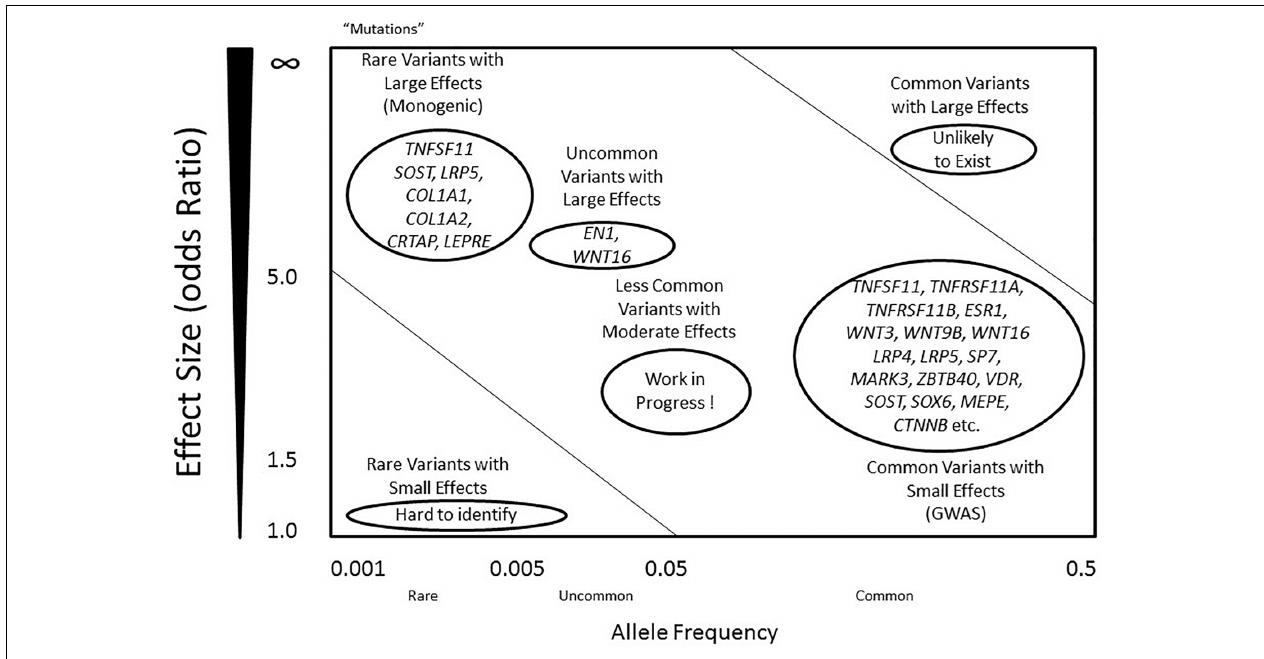
FIGURE 1 | Genetic predisposition and architecture in osteoporosis. Allele frequency is defined as below: common ( < 0.5), uncommon ( < 0.05), and rare ( < 0.005). Mutations are considered as rare variants, mostly with an allele frequency less than 0.001, often with large effect sizes. Alleles that contribute to regulation of BMD include rare variants with large effects (left top), and common variants with small effects (right bottom). A few genes such as COL1A1 and LRP5 include variants that contribute to the phenotypes in either dominant or recessive mechanisms. However, most common variants within the genes present small effects, including RANK , RANKL , OPG and LRP4 . Common variants with large effects are unlikely to exist, while rare variants with small effects are difficult to identify using current technology. Less common variants with moderate effects are likely to exist, and they may explain the majority of the missing heritability of osteoporosis.